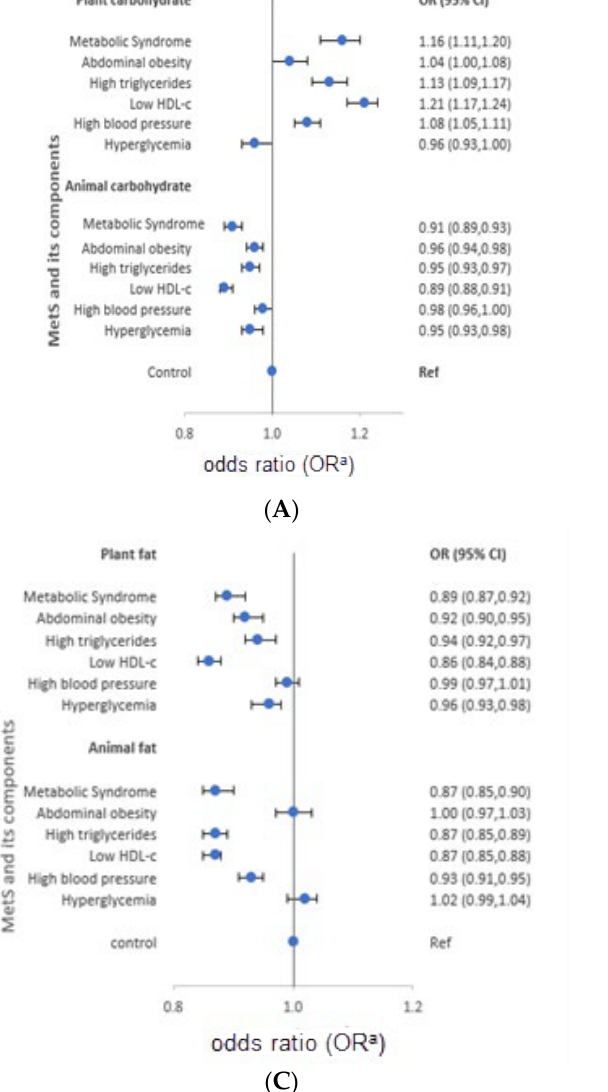
Figure 3. Odds ratios (OR) and 95% confidence intervals (CI) of metabolic syndrome and its components stratified by source of macronutrients in women, the HEXA-G study, 2004–2013. ( A ) plant and animal-source carbohydrates…( B ) plant and animal-source proteins…( C ) plant and animal source fats … HDL-c: High density lipoprotein cholesterol. a Adjusted for age, body mass index, marital status, education, family income, occupation, smoking, drinking, regular exercise, energy intake, and menopausal status.